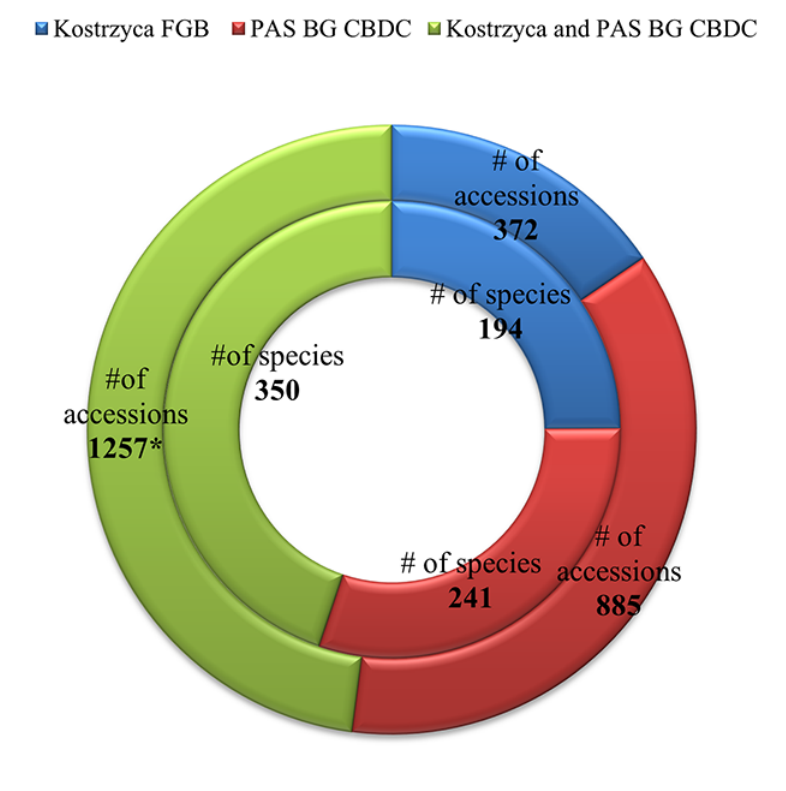
Figure 3 Structure of the cryogenic collection of seeds of herbaceous plants in relation to the storing institutions: Kostrzyca Forest Gene Bank (Kostrzyca FGB) and Polish Academy of Sciences Botanical Garden – Center for Biological Diversity Conservation in Powsin, Warsaw (PAS BG-CBDC) (* including duplicated accessions in both institutions). # –